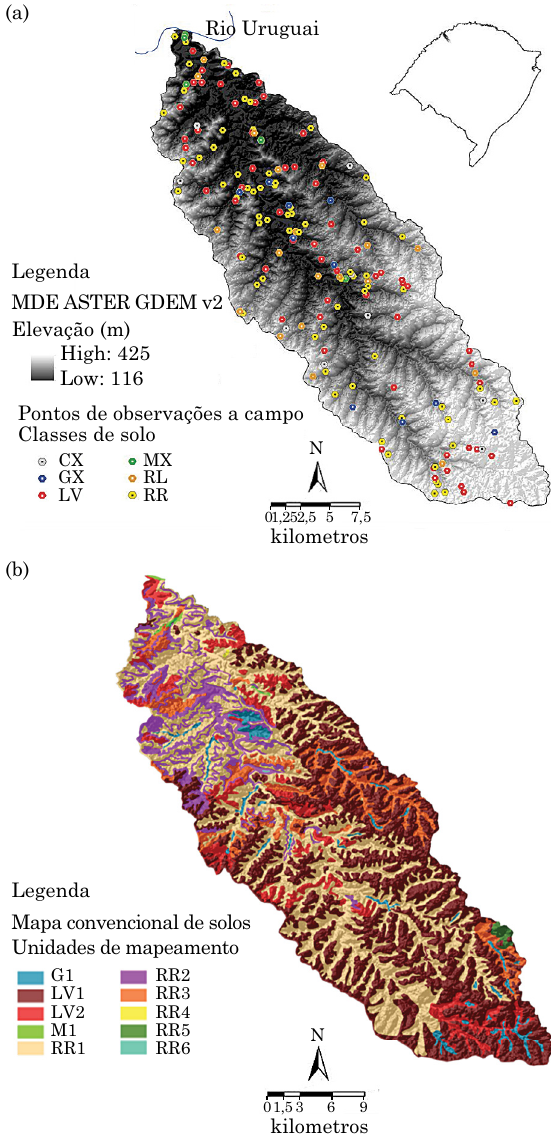
Figura 1. (a) modelo digital de elevação asTer gdem v2 com a distribuição espacial dos locais em que os perfis de solo foram examinados, sendo CX: Cambissolo Háplico, gX: gleissolo Háplico, lV: latossolo Vermelho, mX: Chernossolo Háplico, rl: neossolo litólico, rr: neossolo Regolítico; e (b) Mapa convencional de solos da bacia do Rio Santo Cristo (Kämpf et al.,